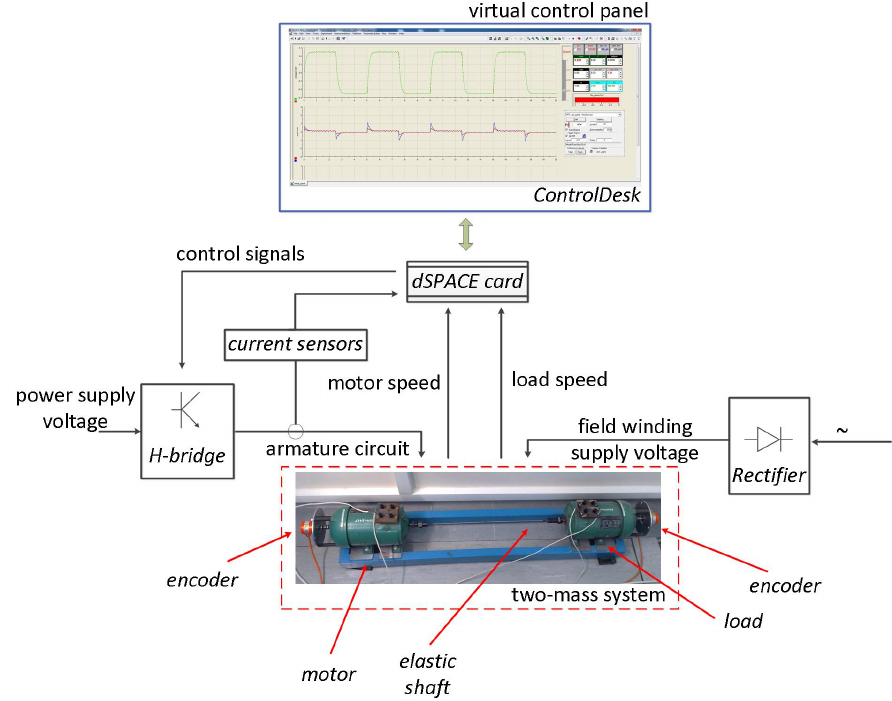
Figure 7. Topology of the drive used in